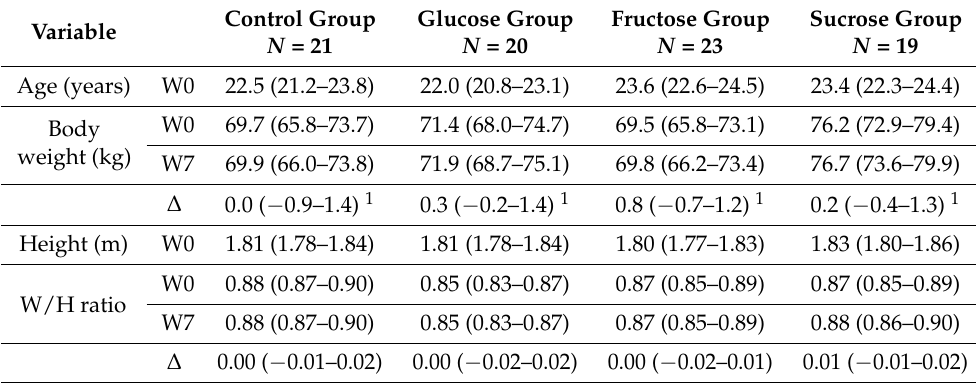
Table 1. Anthropometric characteristics at baseline (W0) and after intervention